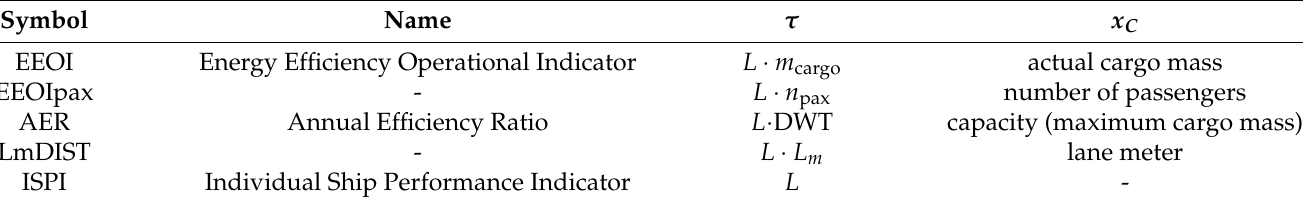
Table 1. Some CIIs after [2,7,8]. Proxy of transport work τ ( L , x C ) and its argument x C are also provided. L represents voyage